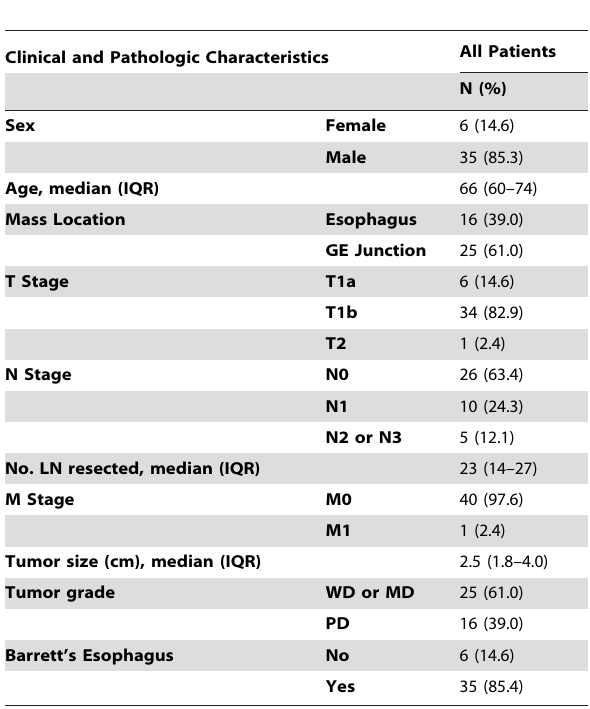
Table 1. Clinical and Pathologic Characteristics of the Study